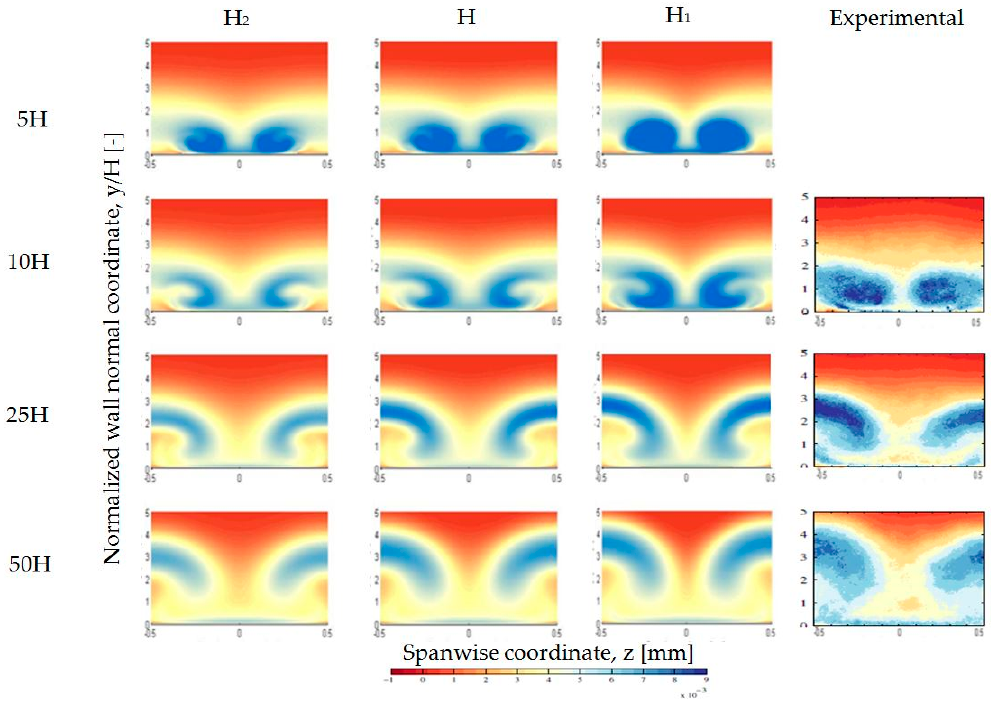
Figure 10. Comparison of the normalized turbulence kinetic energy (TKE) K /( U ∞ ) 2 fields between experimental data and numerical simulations. Streamwise plane station from top to bottom: 5H, 10H, 25H, 50H.